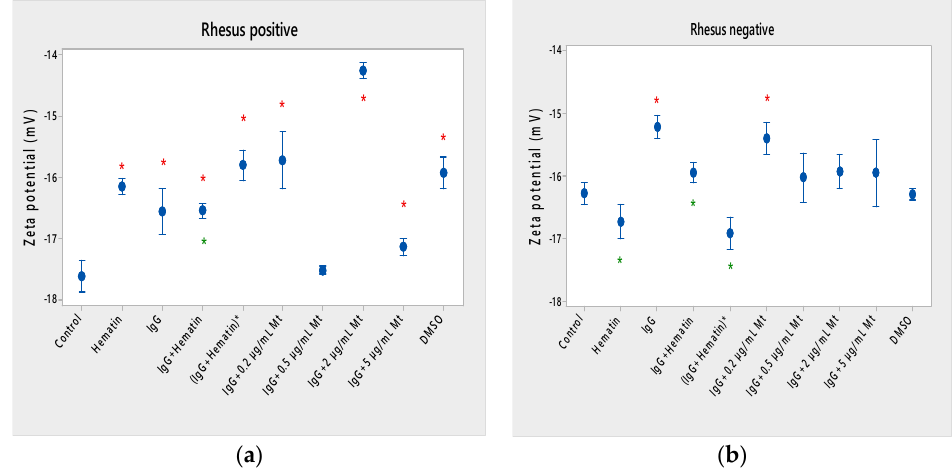
( b ) Figure 2. Effect of fixed concentrations of pooled immunoglobulin G (10 mg/mL), hematin (80 µM) and melittin (0.2 µg/mL Mt; 0.5 µg/mL Mt; 2 µg/mL Mt and 5 µg/mL Mt) treatments on electrophoretic mobility (EPM) (average value ± SD) of erythrocytes ( a ) with a Rhesus-positive factor and ( b ) Rhesus- negative factor suspended in PBS, pH 7.4. The pre-incubated sample of pooled immunoglobulin G (10 mg/mL) with hematin (80 µM) is indicated by an asterisk on the abscissa. Erythrocytes were treated with biomacromolecules for 1 h at 37 °C. Electrophoretic mobility was performed at 25 ± 0.1 °C in phosphate buffered saline (PBS), pH 7.4. Each value was the mean ± SD of three independent preparations. *** p < 0.001; ** p < 0.01; * p < 0.05 compared to the untreated control and compared to DMSO (80 µM)-treated control (green asterisks).